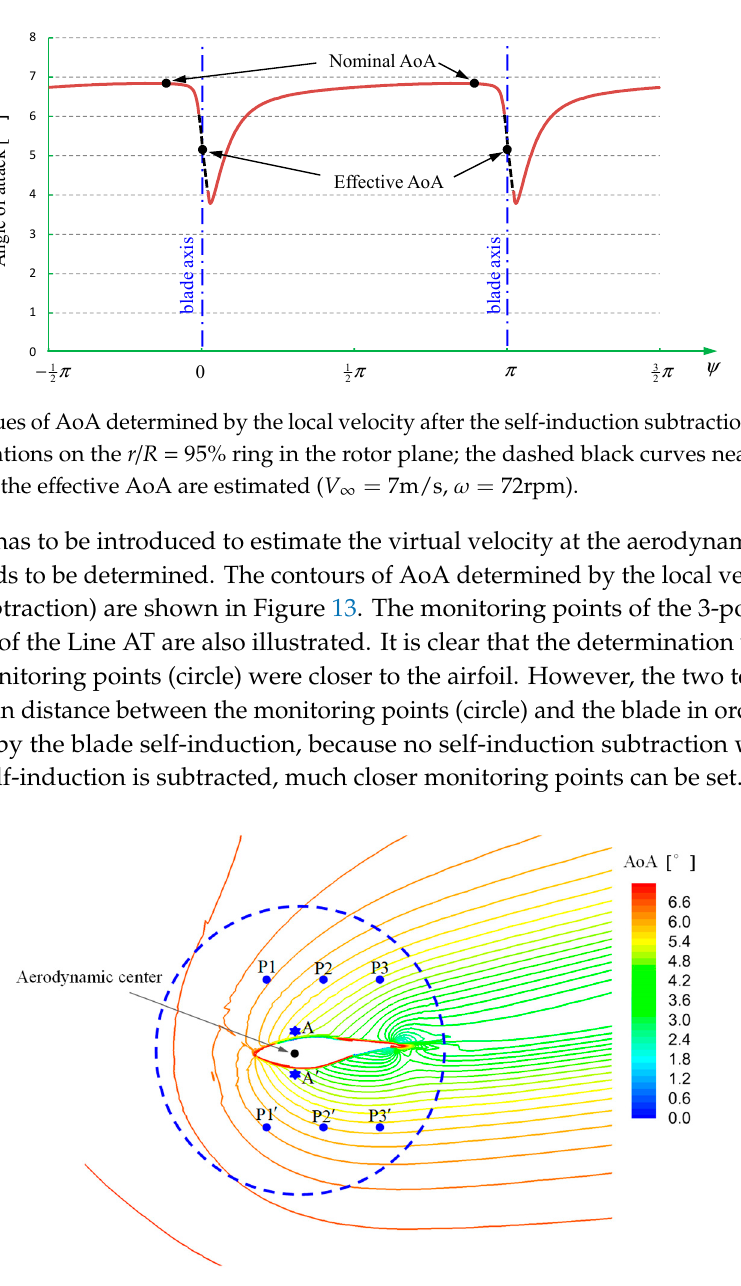
Figure 13. Contours of AoA determined by the local velocity after the self-induction subtraction in the